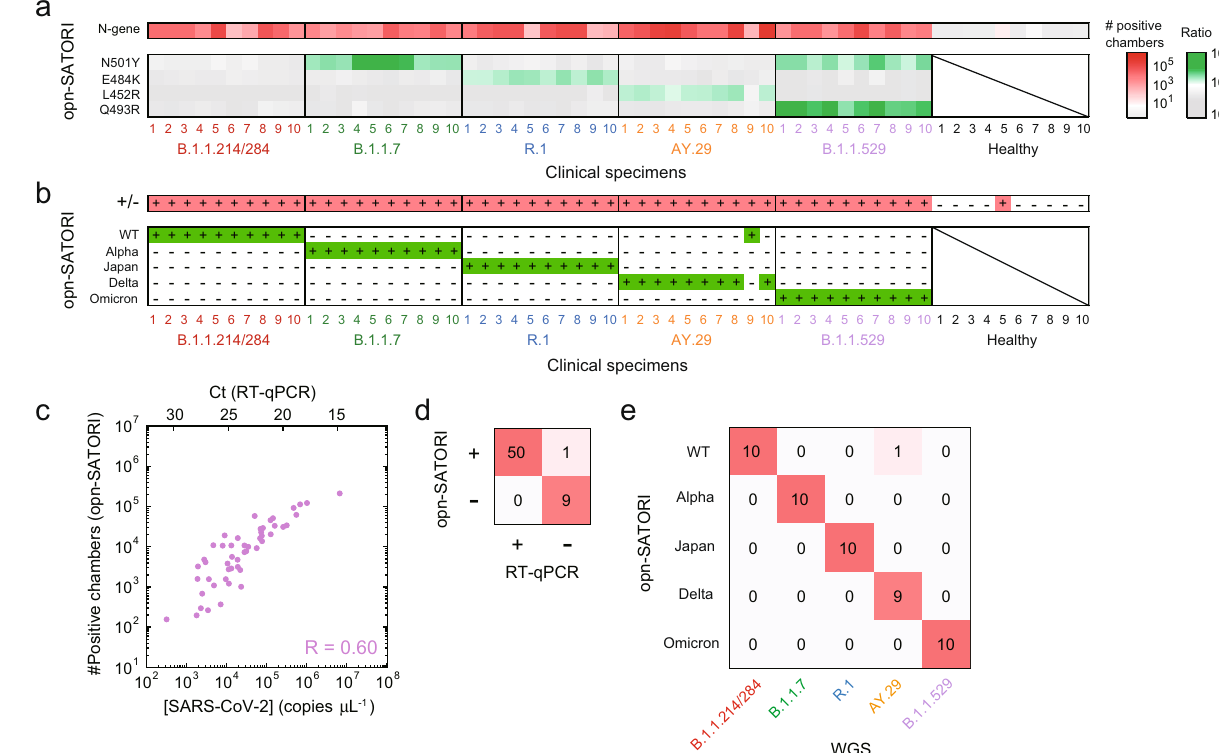
Fig. 4 Clinical validation. a , b Detection of SARS-CoV-2 variants, and discrimination of the S-gene mutations in clinical specimens. B.1.1.214/284, B.1.1.7, R.1, AY.29, and B1.1.529 were WT, alpha, Japan, delta, and omicron variants, respectively. The de fi nition of having a mutation is that the ratio value is greater than 1.0. c Comparison of opn-SATORI and RT-qPCR for quanti fi cation of the SARS-CoV-2 genomic RNA copy number. d Comparison of opn- SATORI and RT-qPCR results in SARS-CoV-2 detection. e Comparison of opn-SATORI and WGS results in variant mutations in the B.1.1.529 ( ο ) variant to successful discrimination of Preparation of the Cas13a proteins . For expression of LtrCas13a and LwaCas13a, Escherichia coli Rosetta 2 (DE3) was transformed with the pET-LtrCas13a or pET- LwaCas13a plasmids, and the cells were cultured in 2.5 L of LB medium containing kanamycin. When the OD 600 values reached 0.6 – 1.0, the cells were cooled on ice